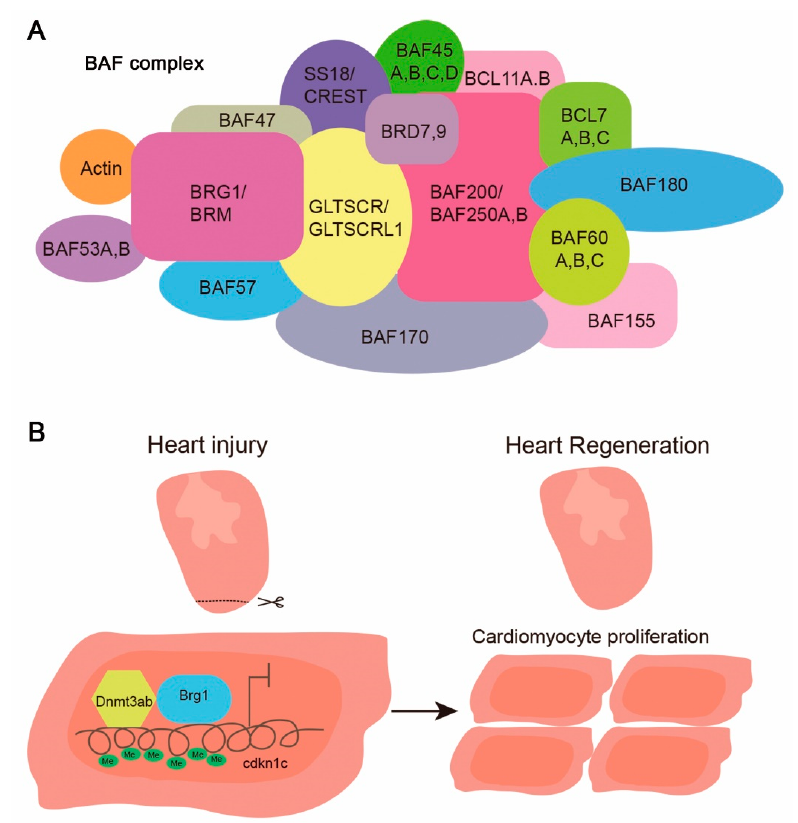
Figure 2. Composition of the mammalian SWI/SNF complex and Brg1 function in zebrafish heart regeneration. ( A ) Subunit composition of the mammalian SWI/SNF complex; ( B ) Cartoon showing how Brg1 regulates zebrafish cardiomyocyte proliferation and regeneration via a derepression mechanism. The injury-induced Brg1, via its interaction with Dnmt3ab, inhibits the expression of cdkn1c by increasing the methylation level of CpG sites at the cdkn1c promoter